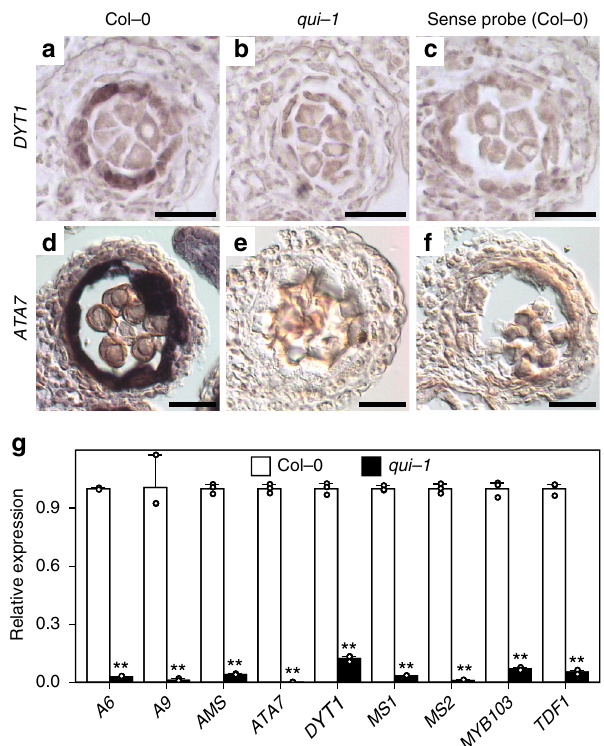
Fig. 3 BES1 family members are essential to tapetum development and function. a – f In situ hybridization analyses of DYT1 ( a – c ) and ATA7 ( d – f ) in the anthers of Col-0 ( a , d , c , f ) and qui-1 ( b , e ). Hybridization signals can be detected in stage 6 and stage 8 anthers of Col-0 ( a , d ), but not in the same- stage anthers of qui-1 ( b , e ), respectively. Sense probe was used as negative controls ( c , f ). Scale bars represent 20 μ m. g Quantitative PCR analysis results to show relative expression levels of several tapetum marker genes in the in fl orescences of Col-0 and qui-1 . Data are presented as mean and s.d. ( n = 3). Asterisks indicate signi fi cant differences ( P < 0.01, two-tailed